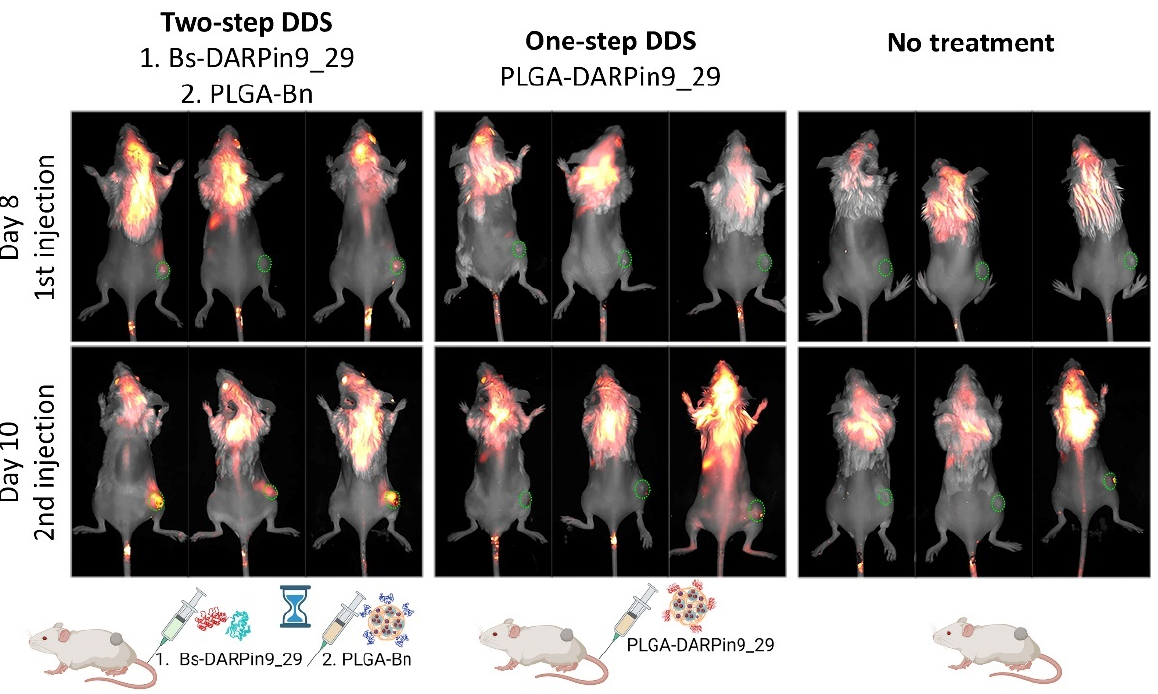
Figure 5. Imaging of BALB/c mice with EMT-HER2 tumors after the first and second injections of the one-step DDS, PLGA*DARPin9_29 particles, or two-step DDS, Bs-DARPin9_29 and PLGA-Bn, in comparison with the control group. Green circles indicate tumor area. Imaging was performed with LumoTrace FLUO bioimaging system with fluorescence excitation using a 730 nm and 780 nm long-pass filter, thus registering the PLGA particles’ fluorescence.